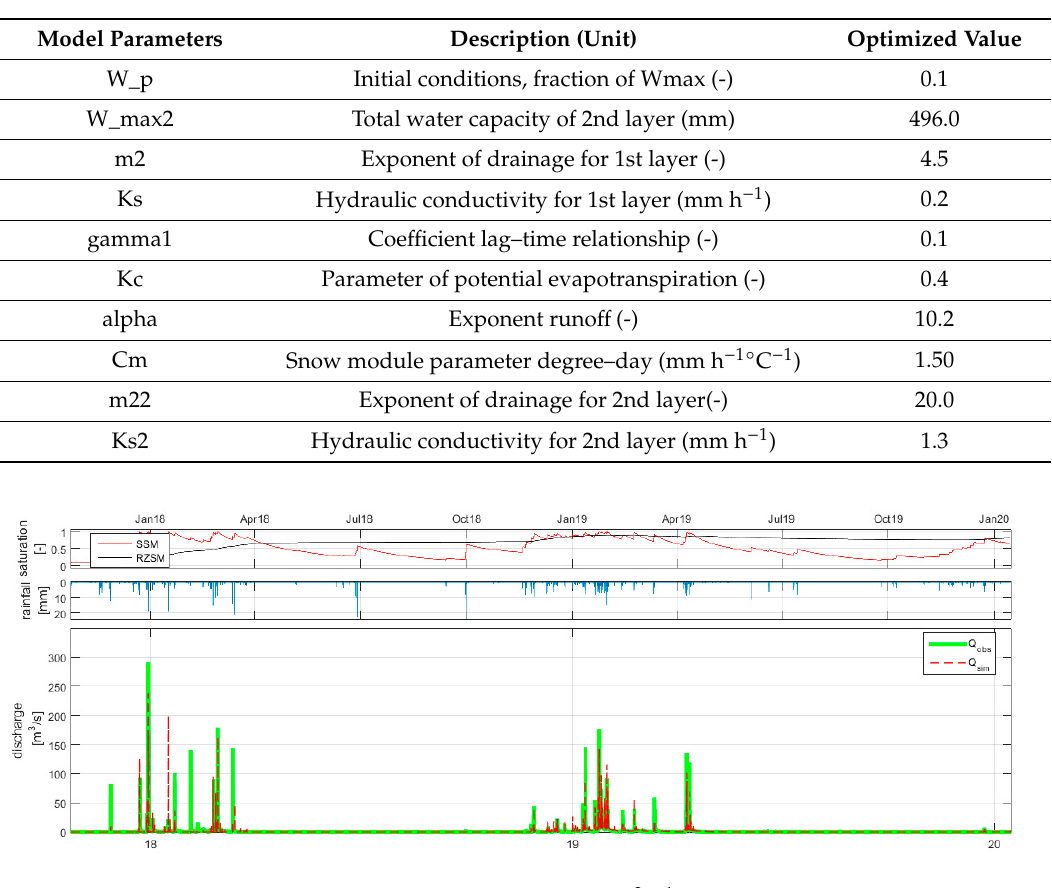
Figure 4. Comparison of the observed and simulated flow (m 3 s − 1 ) (hourly values) for the catchment during the calibration period. The temporal pattern of soil saturation and rainfall is also shown in the upper panels.